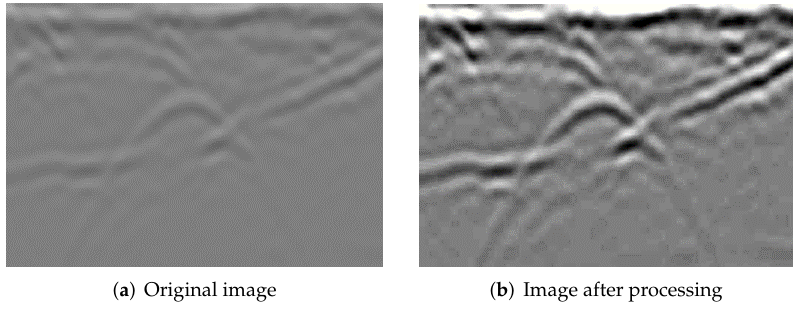
Figure 2. Processing of the first category.